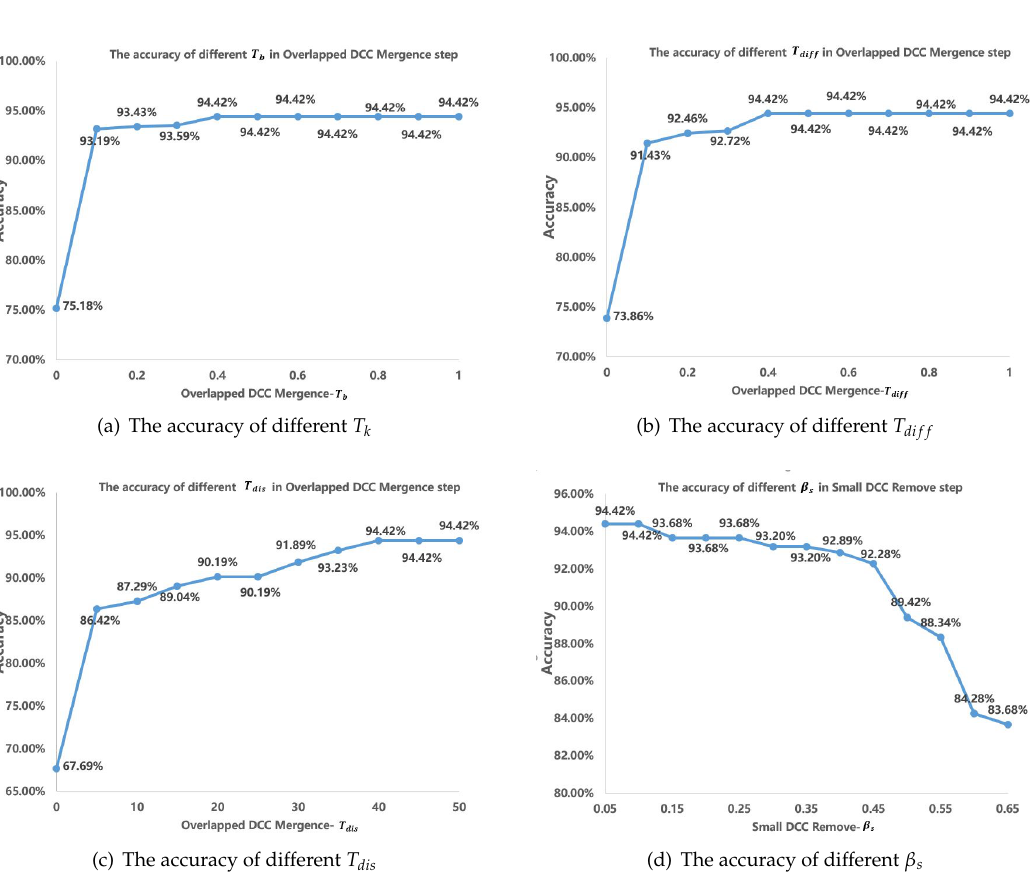
Figure 11. The effect of different